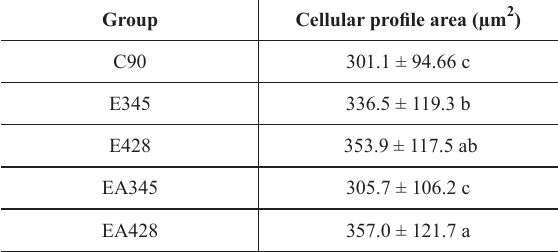
Cellular profile area (cell body) of the myosin-V immunoreactive myenteric neurons in the duodenum of rats at different ages: C90 days, E 345 days, E428 days, and supplemented with ascorbic acid: EA 345 and EA 428 days (n = 500 cells/group). Data were expressed as mean ± standard deviation.